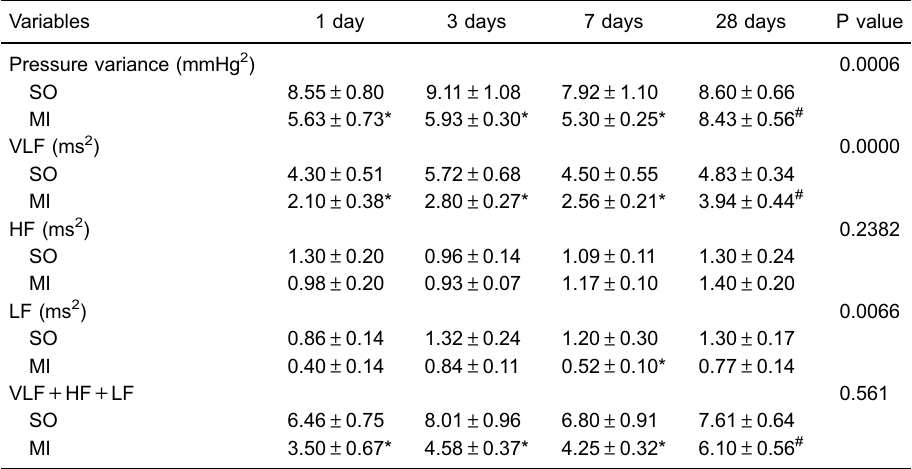
Table 3. Parameters of time and spectral systolic blood pressure variability in sham-operated (SO) and infarcted (MI) rats studied at different times after surgery. Variables